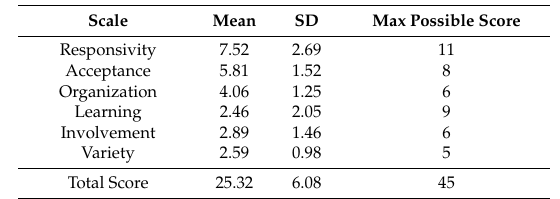
Table 2. HOME 1 Inventory scores ( n = 1893).